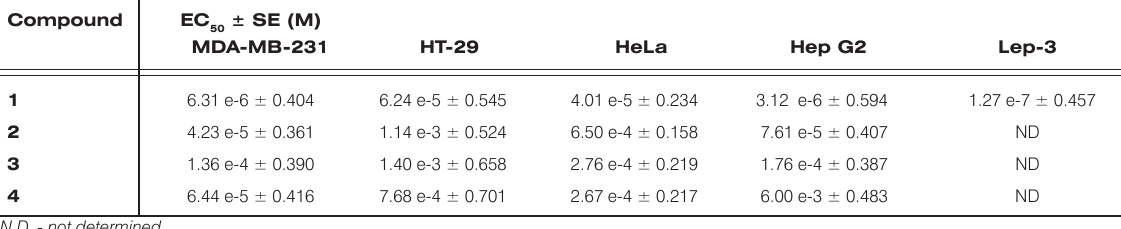
N.D. - not determined Table 2. In vitro suppresion of Lep-3